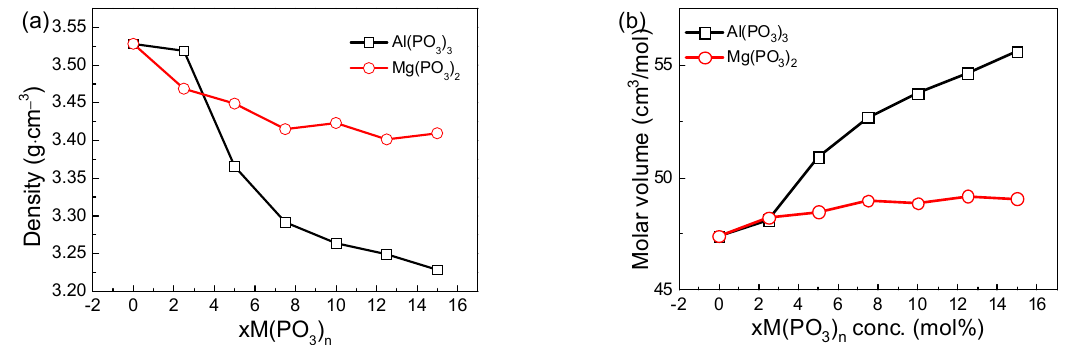
Figure 2. Variation of ( a ) Density and ( b ) Molar volume with respect to M(PO 3 ) n concentration in (70-x)V 2 O 5 -5ZnO-22BaO- 3B 2 O 3 -xM(PO 3 ) n (where M = Al, Mg, n = 3, 2, respectively, mol%) glass system.